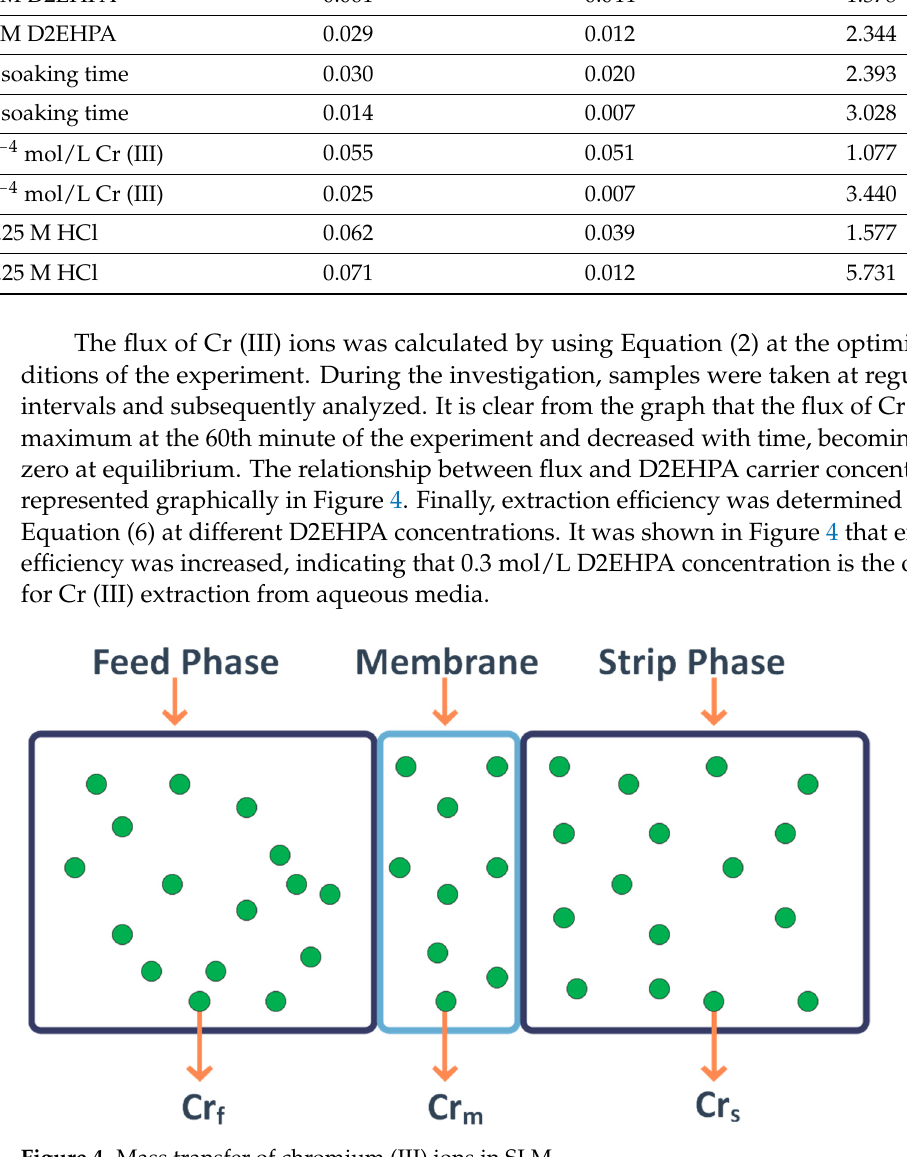
Table 2. Distribution coefficient (KD) at the 60th and 240th minutes of the experiment.